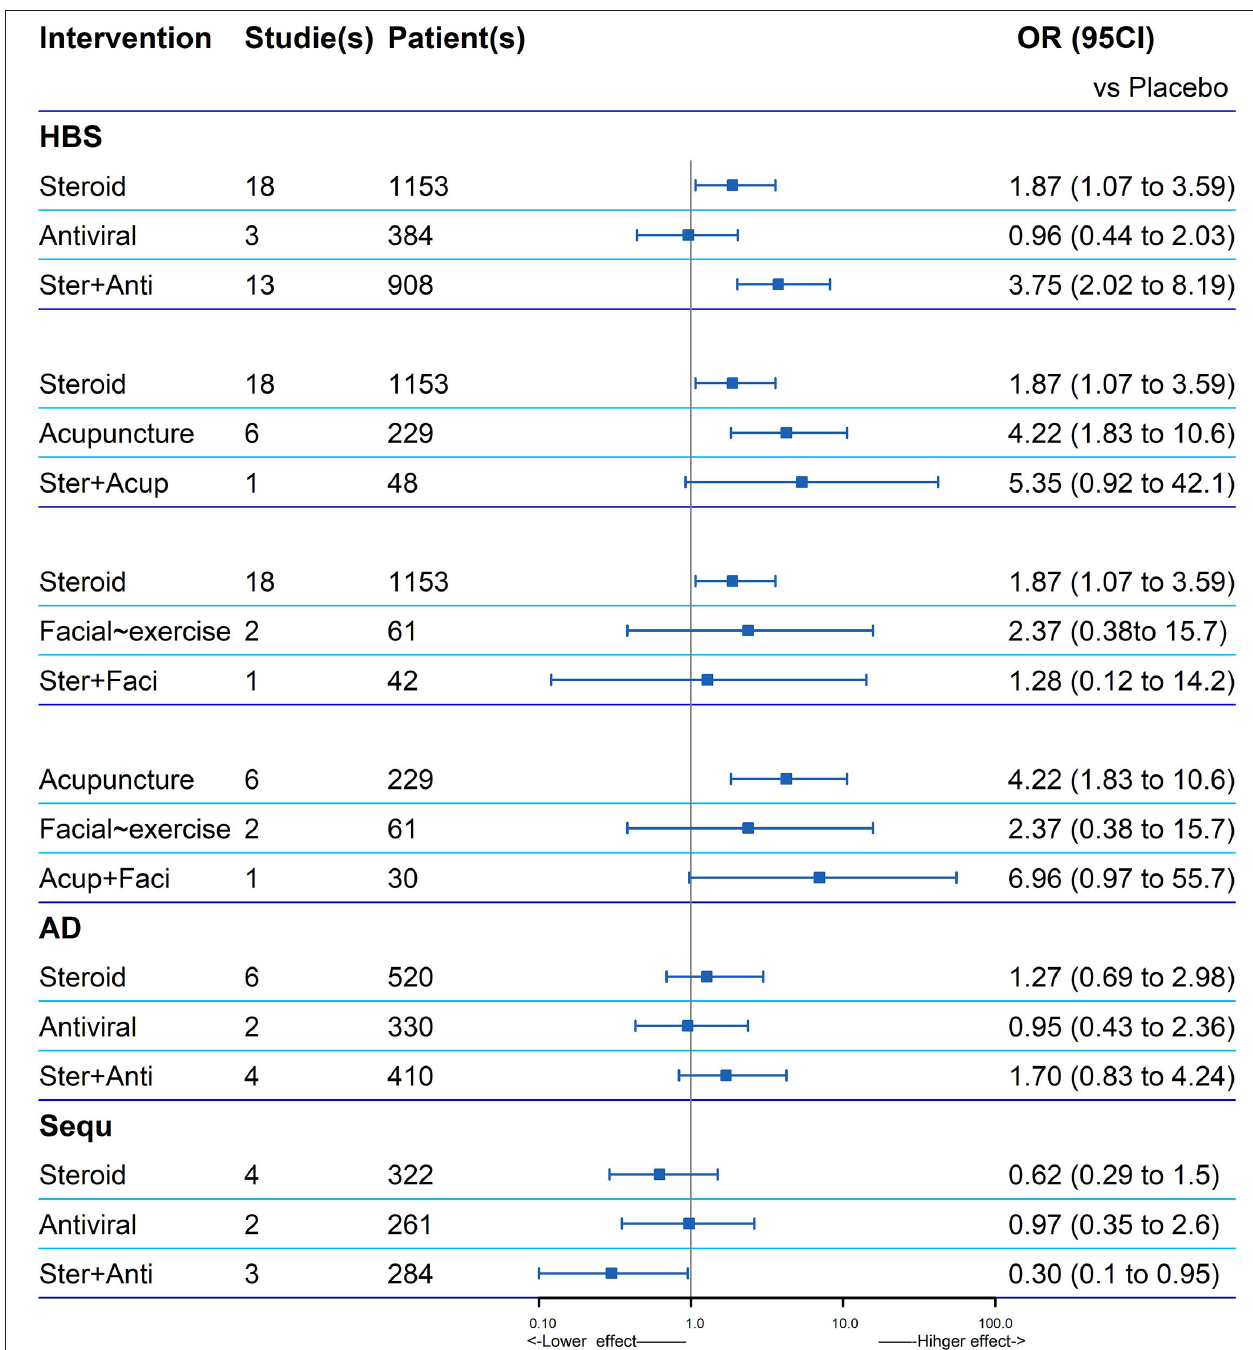
FIGURE 4 | Explore of potential interaction of four combined treatments and their corresponding single treatment for the facial recovery. If one is not contained in the 95% CI of the combination therapy, the two single treatments in the combination therapy are considered to have a positive interaction significantly (HBS, House–Brackmann scale; AD, adverse events; Sequ, sequelae; Ster, Steroid; Anti, antiviral; Acup, Acupuncture; Faci, Facial exercise).